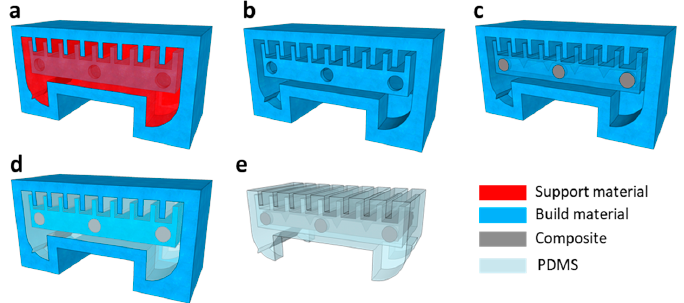
Figure 3. Fabrication process of WIBot using three-dimensional (3D)-printed soluble mold technique. ( a ) 3D-printed WIBot mold. ( b ) Mold with support material removed. ( c ) Injection of Fe 3 O 4 /PDMS composite only into inner mold and curing. ( d ) Casting of evenly mixed PDMS into mold. ( e ) Completed robot after mold dissolution (build material).